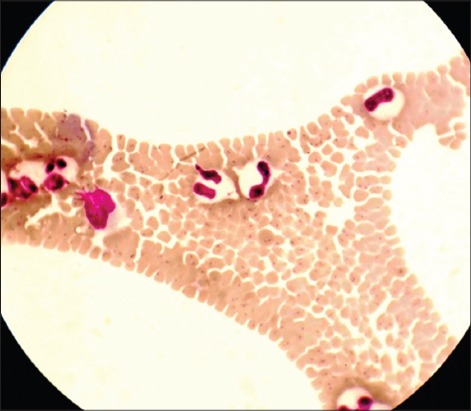
Microscopic examination of giemsa stained blood film showing T. annulata piroplasms in the erythrocytes.